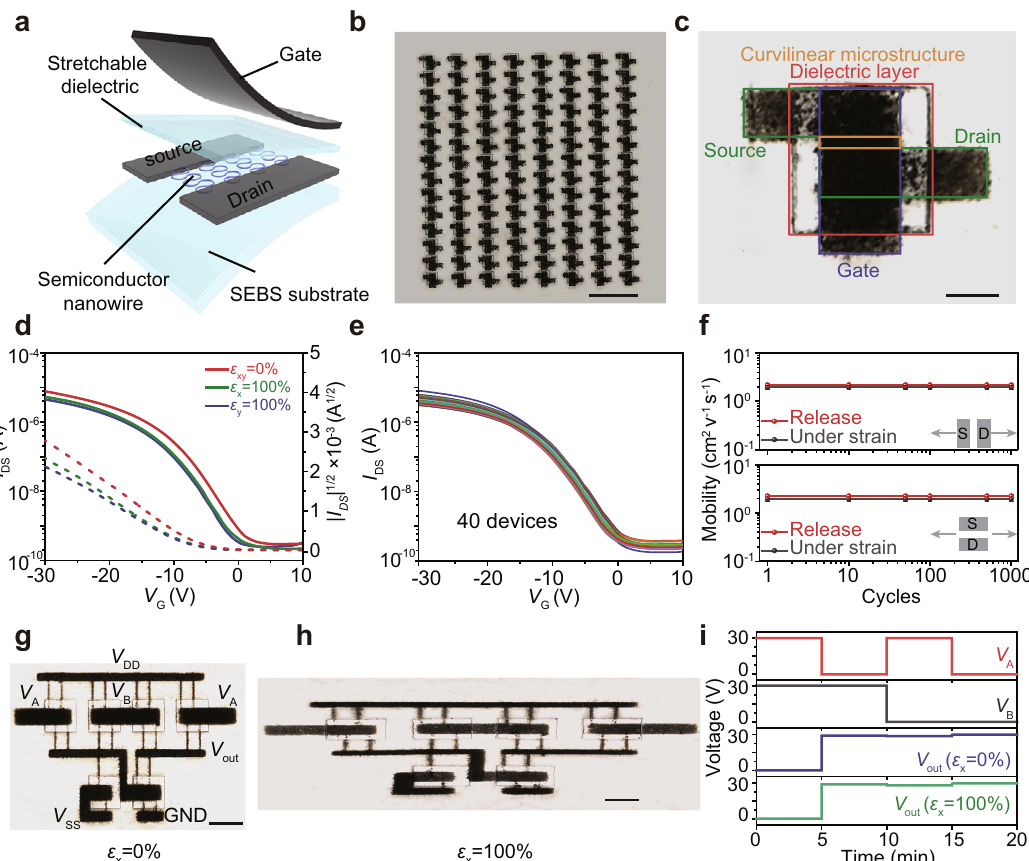
Fig. 3 Electronic performance of fully stretchable OFET arrays. a Schematic illustration of a fully stretchable OFET constructed by curvilinear microstructure arrays as the semiconducting channel, SEBS as gate dielectrics, CNTs as the source, drain, and gate electrodes. b Optical image of 112 fully stretchable OFET arrays. c Zoom-in image of an OFET device with the channel length of 30 μ m, the width of 90 μ m, gate dielectric thickness of 1.2 μ m, and capacitance of 1.5 nF cm − 2 . d Transfer curves of the fully stretchable PDVT-10 polymer OFET ( V D = − 30 V) in the unstretched state and at 100% strain parallel and perpendicular to the charge transport direction. Solid lines and dashed lines are I DS – V GS curves and | I DS | 1/2 – V GS curves of these devices, respectively. e Transfer curves of 40 devices in the 112-transistor arrays at 0% strain. f Statistical mobilities of OFETs during up to 1000 stretch-release cycles at 50% strain parallel ( ε x = 50%) and perpendicular ( ε y = 50%) to the charge transport direction. Each point in ( f ) represents average values obtained from fi ve OFET devices. g , h Optical images of stretchable NAND gate ( g ) in its initial state and ( h ) at 100% applied strain in the horizontal direction, where V A and V B are the input voltages at A and B terminals, respectively. i Output – input characteristic curves of the NAND gate at 0%